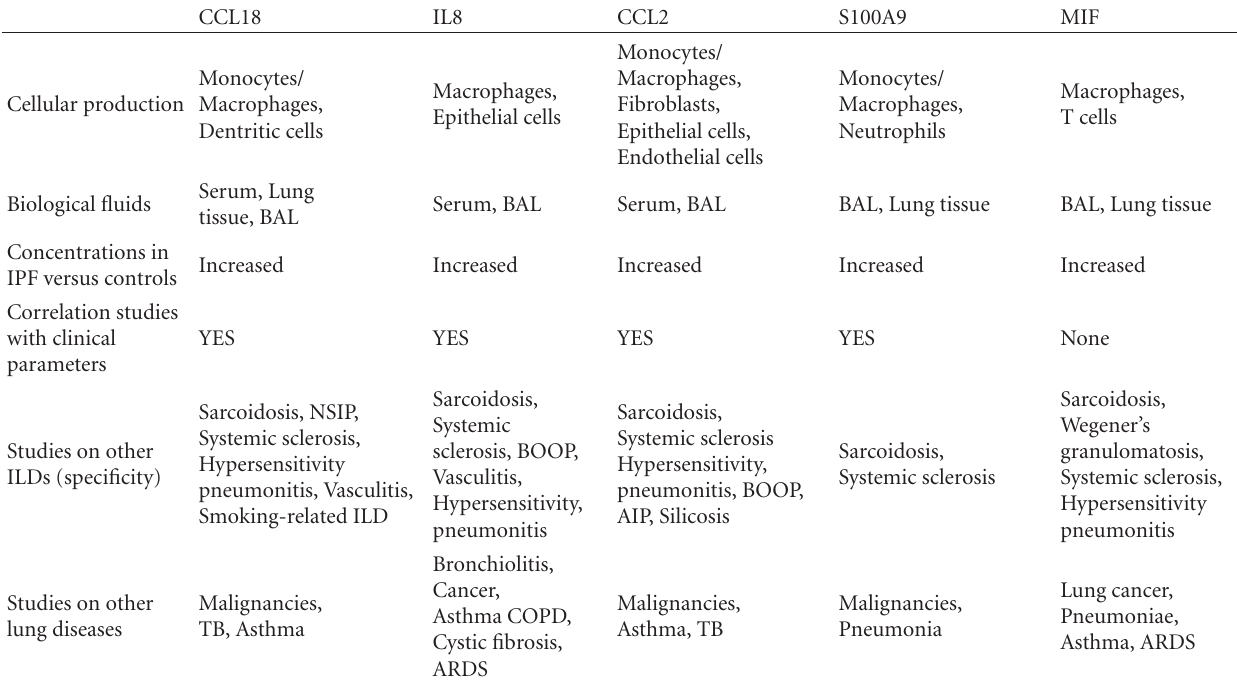
Table 1: The main features of macrophage-derived biomarkers of idiopathic pulmonary